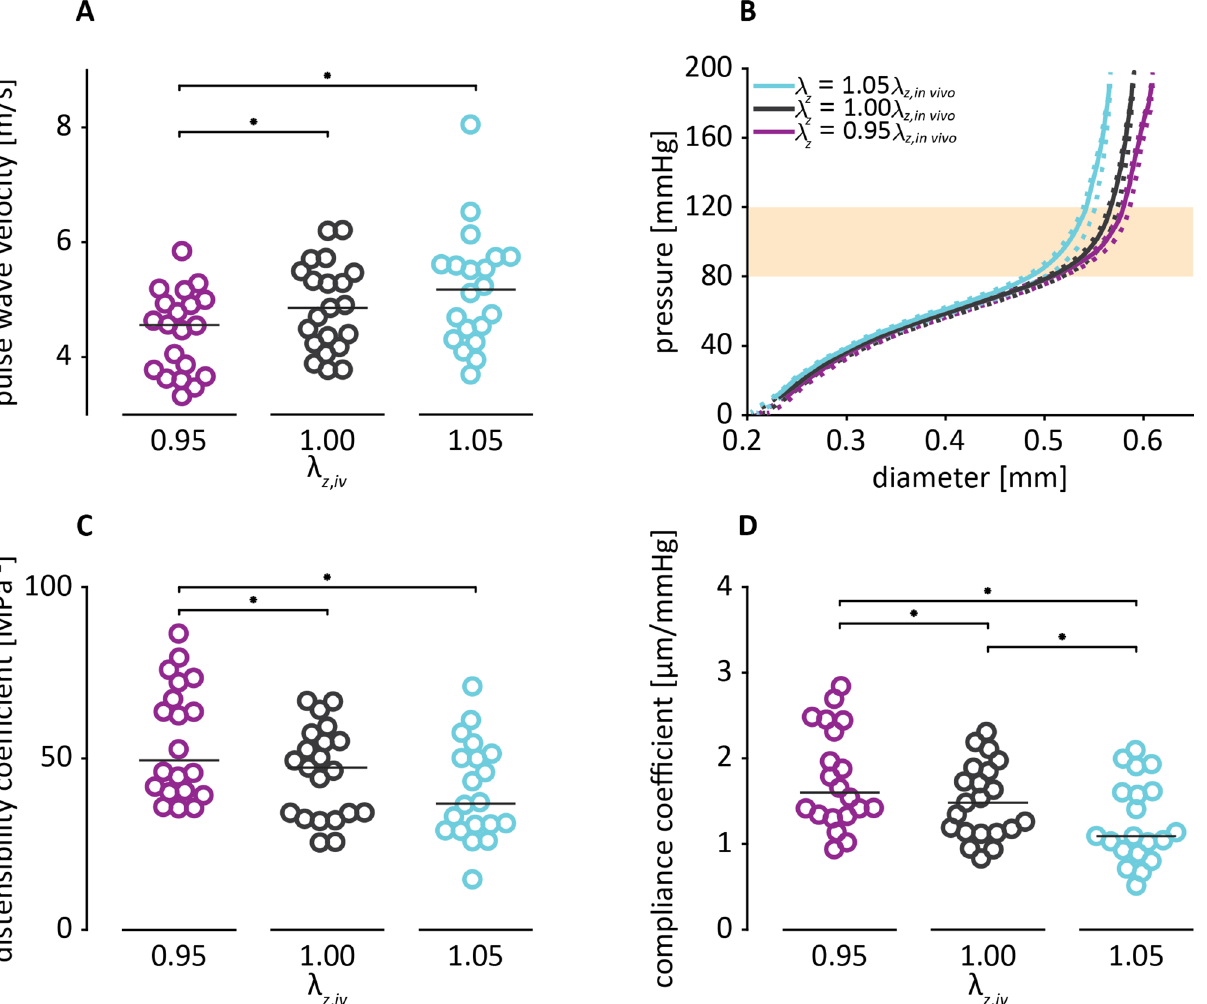
Figure 4. Quasi-static arterial stiffness increased with increasing stretch. ( A ) pulse wave velocity (PWV) determined from quasi-static diameter relationships for different stretch ratios. PWV was determined at 120/80 mmHg (orange area in ( B )). Lines indicate median PWV. ( B ) Representative example of quasi-static pressure-diameter relationships from one vessel at different stretch ratios. Dashed lines reflect the pressure- diameter relation during inflation (ascending line) and deflation (descending line), the straight line reflects the average. ( C ) Distensibility coefficient (DC) determined from quasi-static pressure-diameter curve at reference pressure 120/80 mmHg. ( D ) Compliance coefficient (CC) determined from quasi-static pressure-diameter curve at reference pressure 120/80 mmHg. * p < 0.05, n =